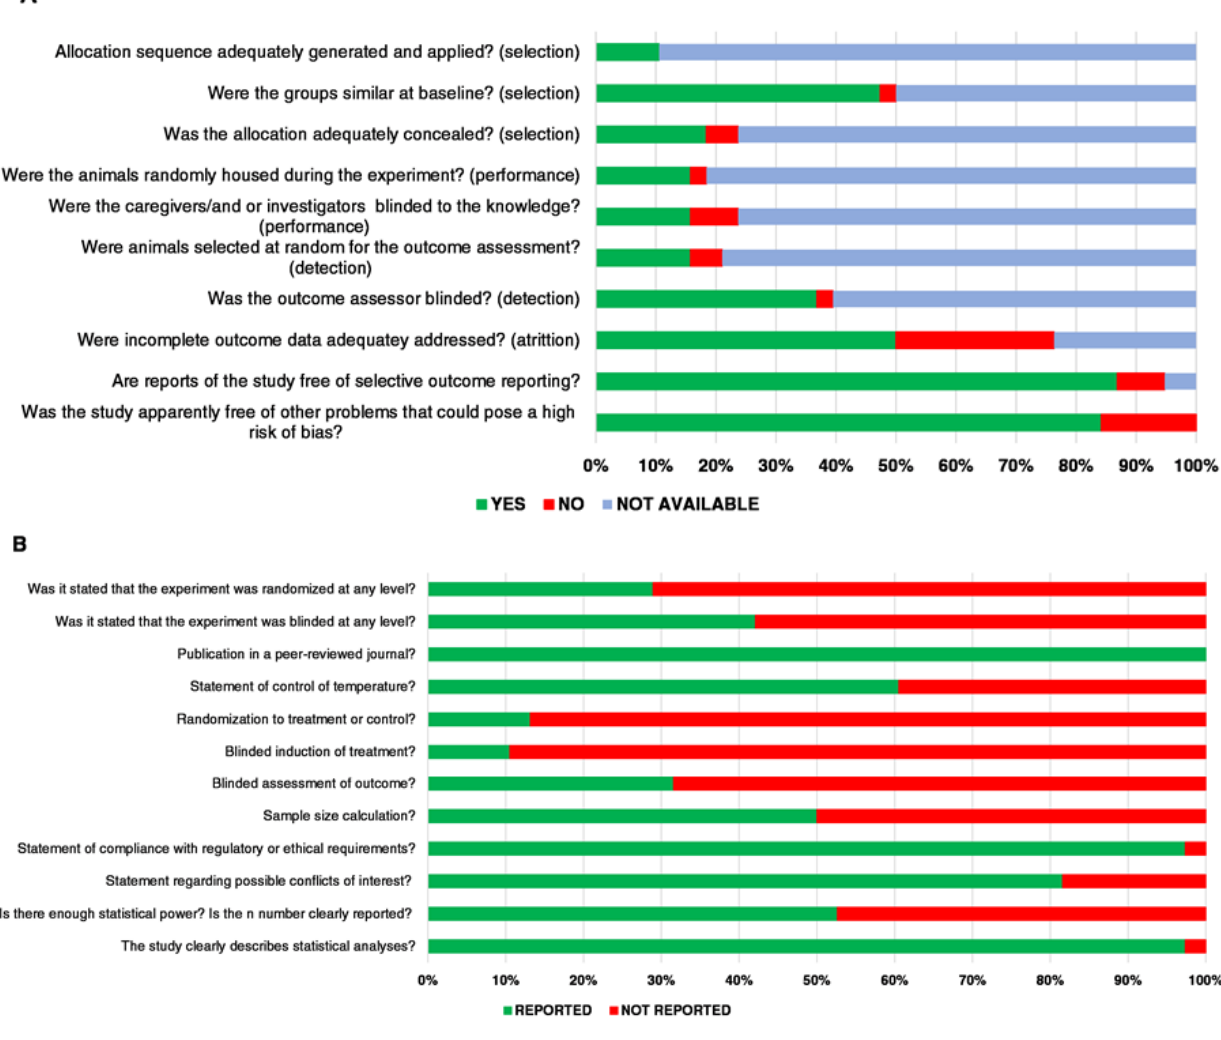
Figure 2. Risk of bias and quality assessment. The SYRCLE RoB Tool was used for assessing risk of bias for the included studies and assessment of study quality based on CAMARADES format. ( A ) Risk of bias assessment. These 10 items assessed selection, performance, detection, and attrition bi- ases. The responses were “yes” for low risk of bias, “no” for high risk of bias, and “not available (N/A)” for unclear or unreported risk. ( B ) Study quality assessment. These 12 items assessed the overall quality of the included studies, stating if they were performed (“reported”) or not (“not re- ported”).